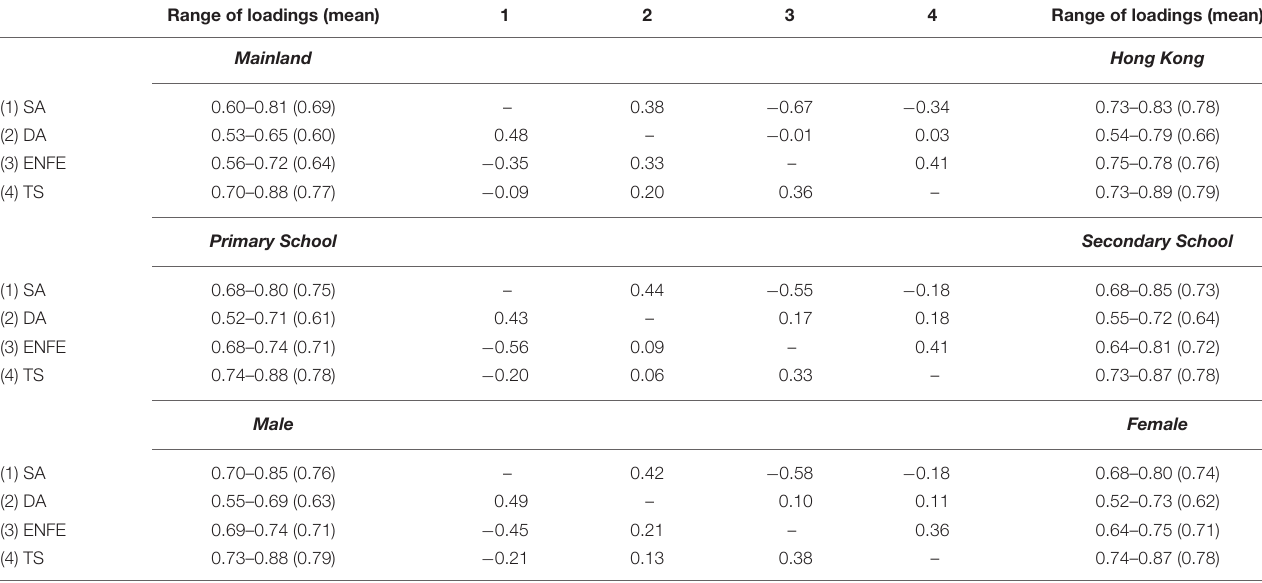
TABLE 2 | Factor loadings and latent factor correlations for